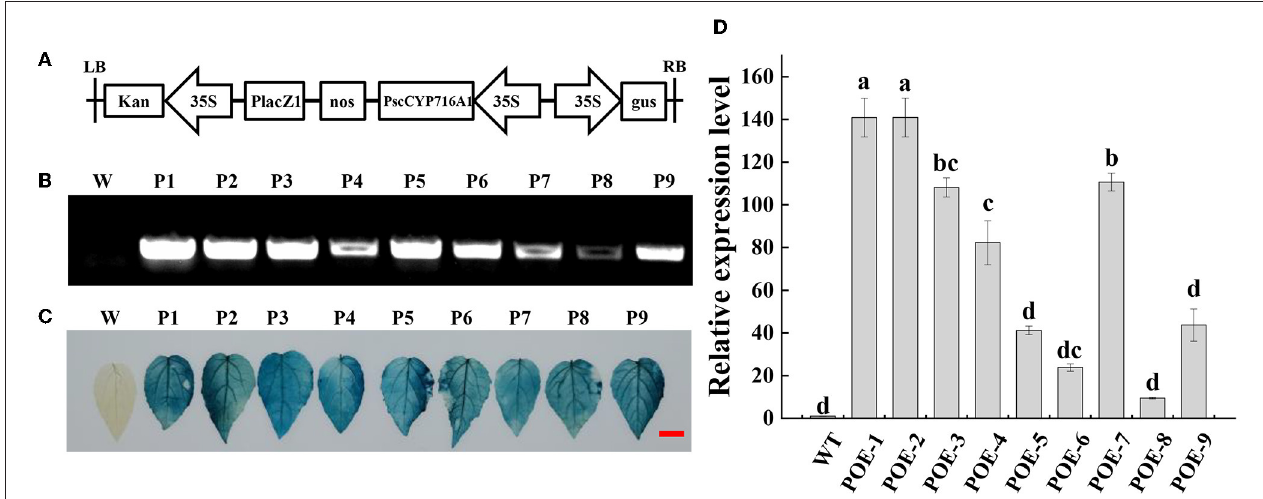
FIGURE 2 | Identification of PscCYP716A1 -overexpressed poplars. (A) Schematic diagram of plant transformation vector pCAMBIA2301- PscCYP716A1 . LB, left border; 35S, CaMV35S promoter sequence; PscCYP76A1, the DNA sequence of PscCYP716A1 in poplar; NOS, NOS terminator; Kan, kanamycin; GUS, GUS reporter gene; RB, right border; (B,C) PCR analysis (B) and GUS staining of leaves (C) ; W: wild-type (WT) poplar, P1-9: PscCYP716A1 -overexpressed lines (POE1-9). (D) RT-PCR analysis, the expression level of WT poplar was set to 1. Data are shown as the mean ± SD of three biological replicates. Different letters indicate significant differences between different plant lines ( p < 0.05).